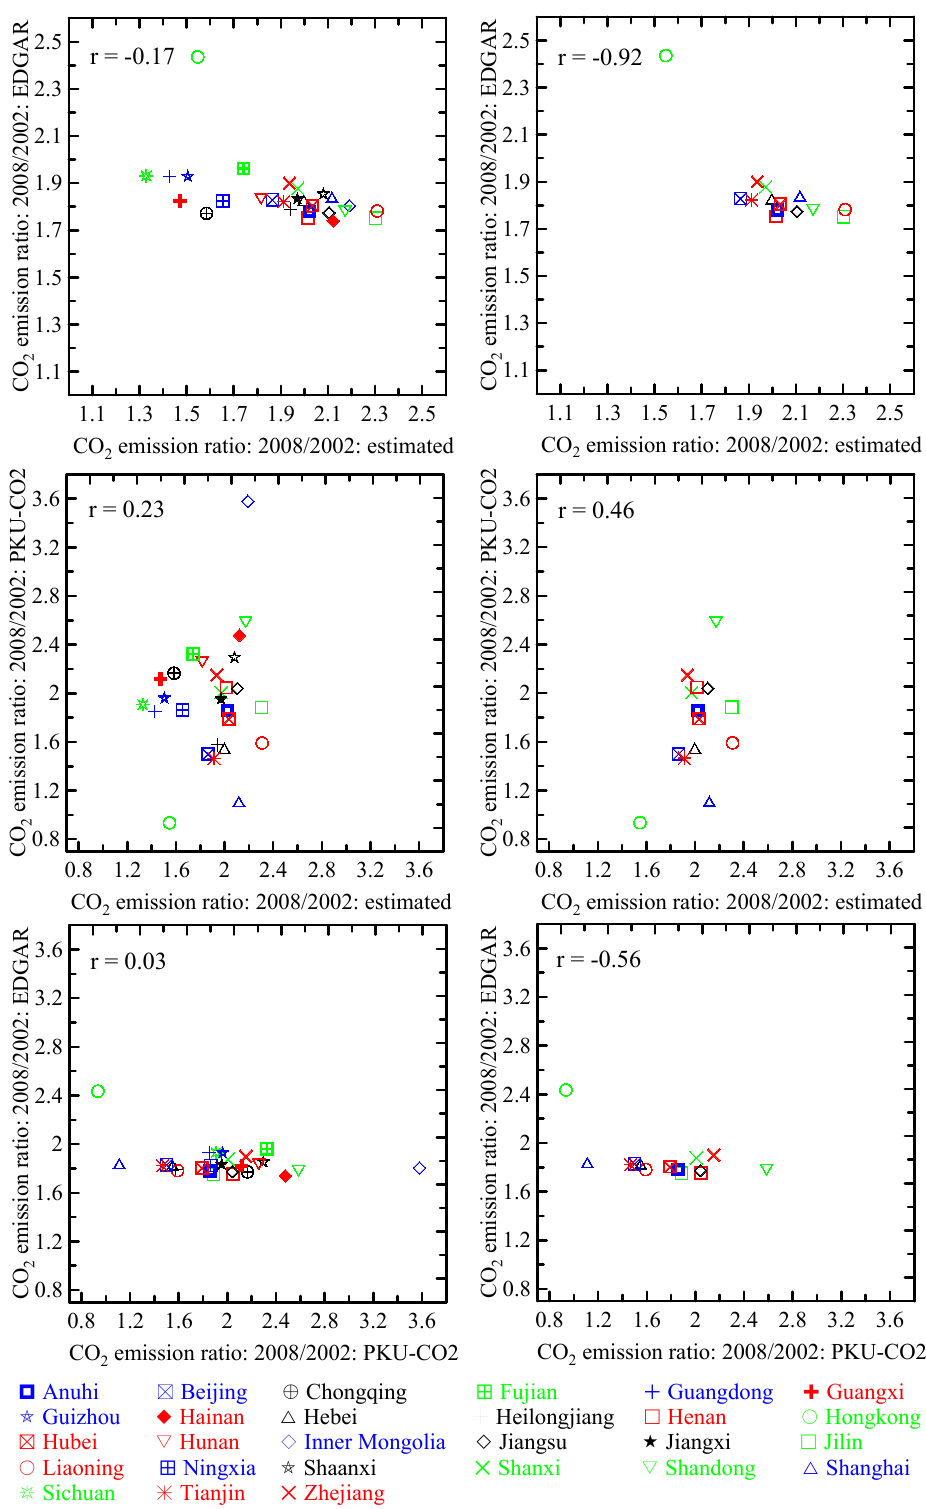
Fig. 10. Scatterplots of the ratios of different CO 2 emission estimates for the years 2008 and 2002: (left) for the eastern provinces depicted in Fig. 3a and (right) for the selected highly polluted provinces indicated in Fig.